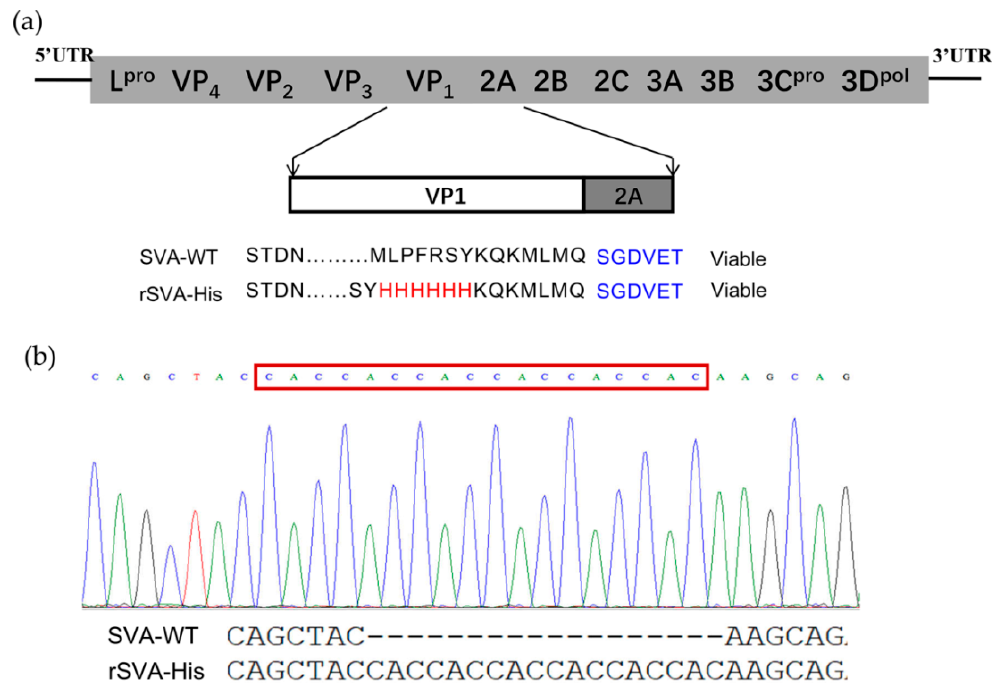
Figure 1. Schematic representation of full-length infectious clone ofrSVA-His and genetic stability analysis. ( a ) The inserted 6 × His-tag sequence is shown in red text surrounded by VP1 residues. 2A residues of SVA are shown in blue text. ( b ) Sequence analysis of rSVA-His after ten passages in BHK-21 cells. The nucleotide sequence encoding 6 × His-tag (CACCACCACCACCACCAC) is shown.